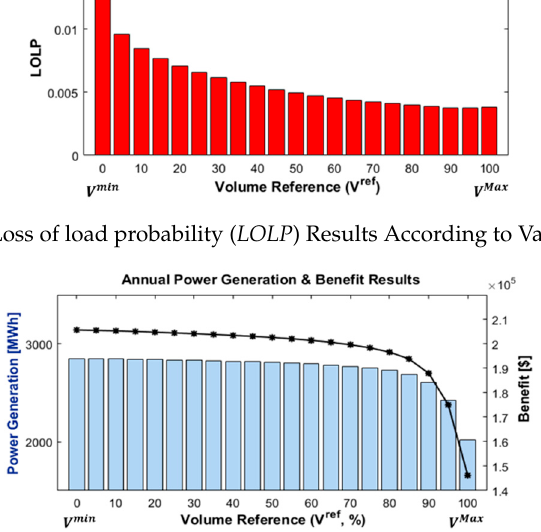
Figure 14. Results of Total Power Output and Benefit of HPP.